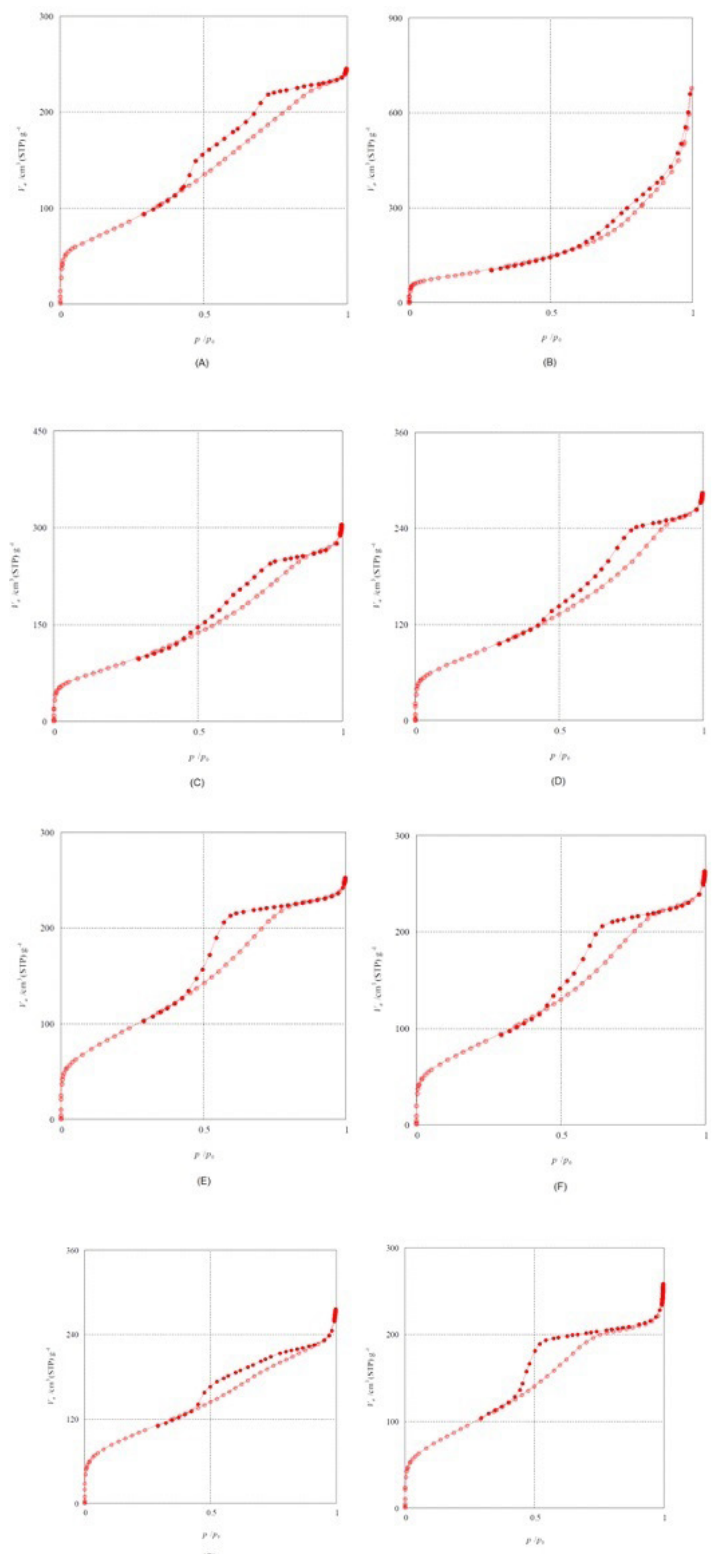
Figure 3. Absorption and desorption isotherms obtained (sample 1 (A), sample 2 (B), sample 3 (C), sample 4 (D), sample 5 (E), sample 6 (F), sample 7 (G), sample 8